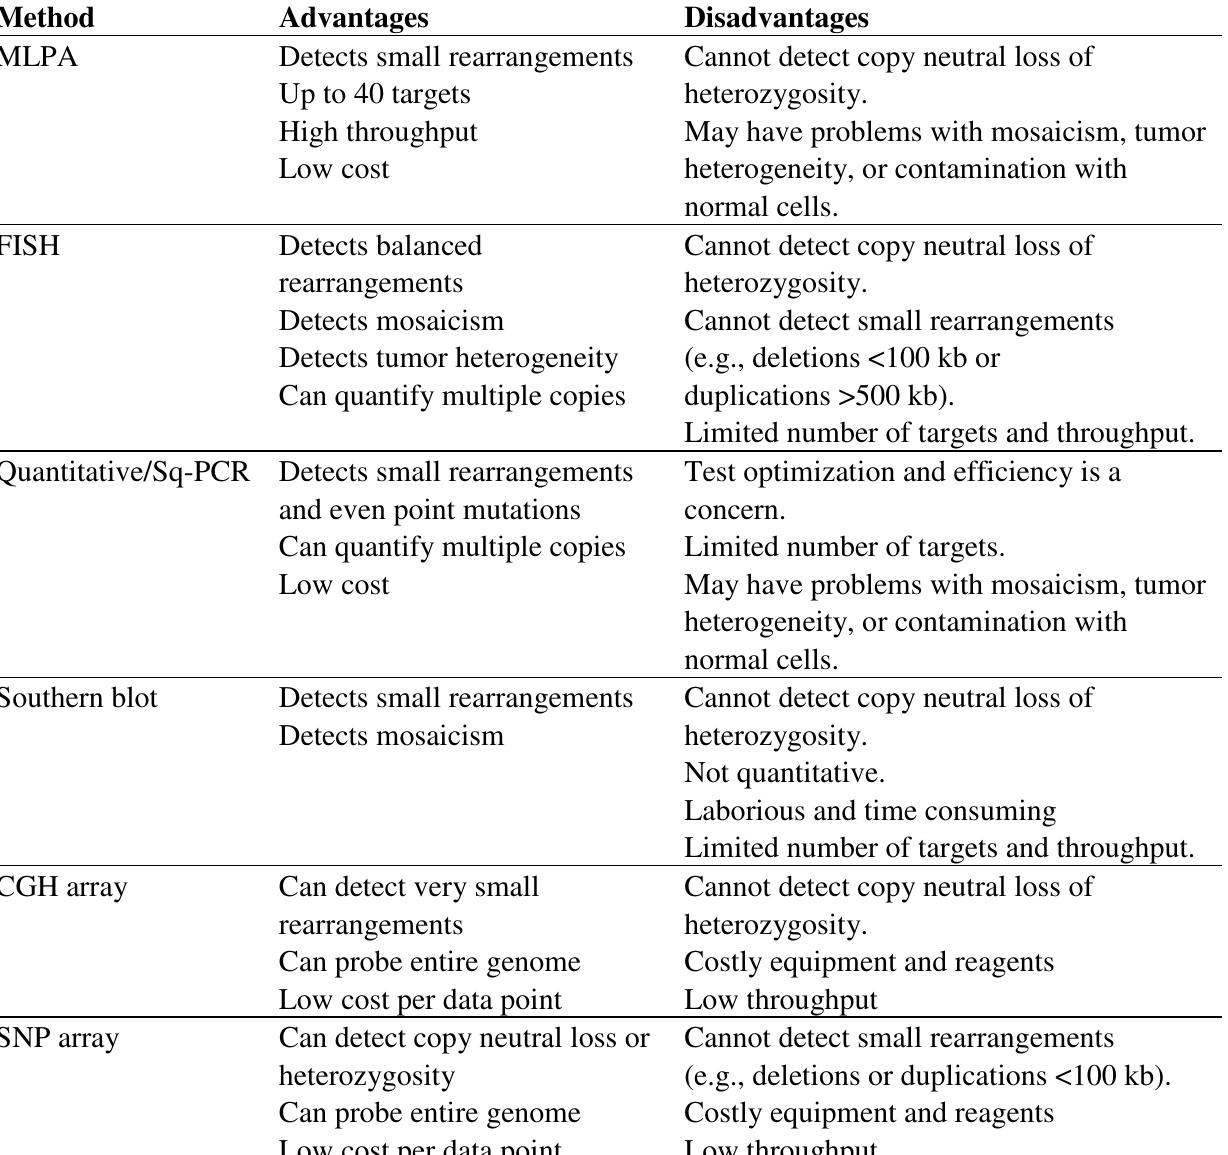
Table 1. Comparison between Multiplex Ligation-dependent Probe Amplification (MLPA) Assay and other methods for the detection of gene